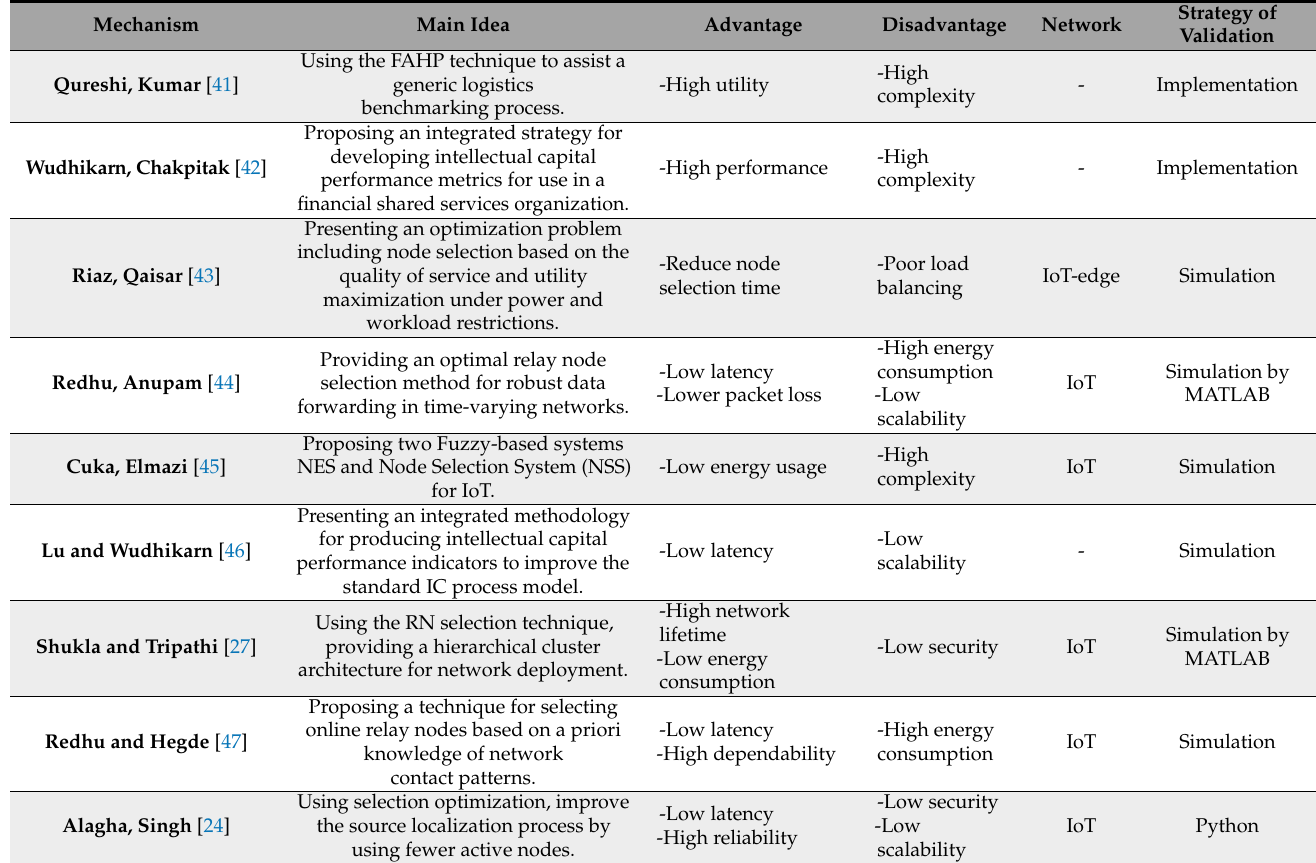
Table 1. A comparison of the discussed IoT